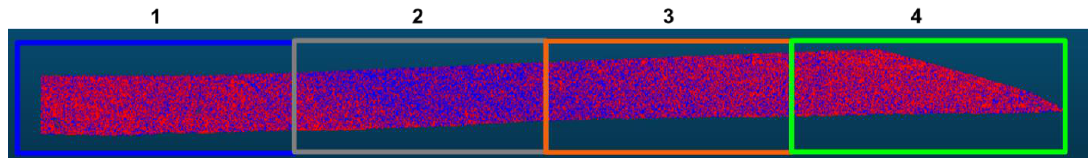
Figure 13. An example of manual extraction of the faces along an MSE wall with piece-wise planar façade (different colors along the MSE wall represent the different registered scans).